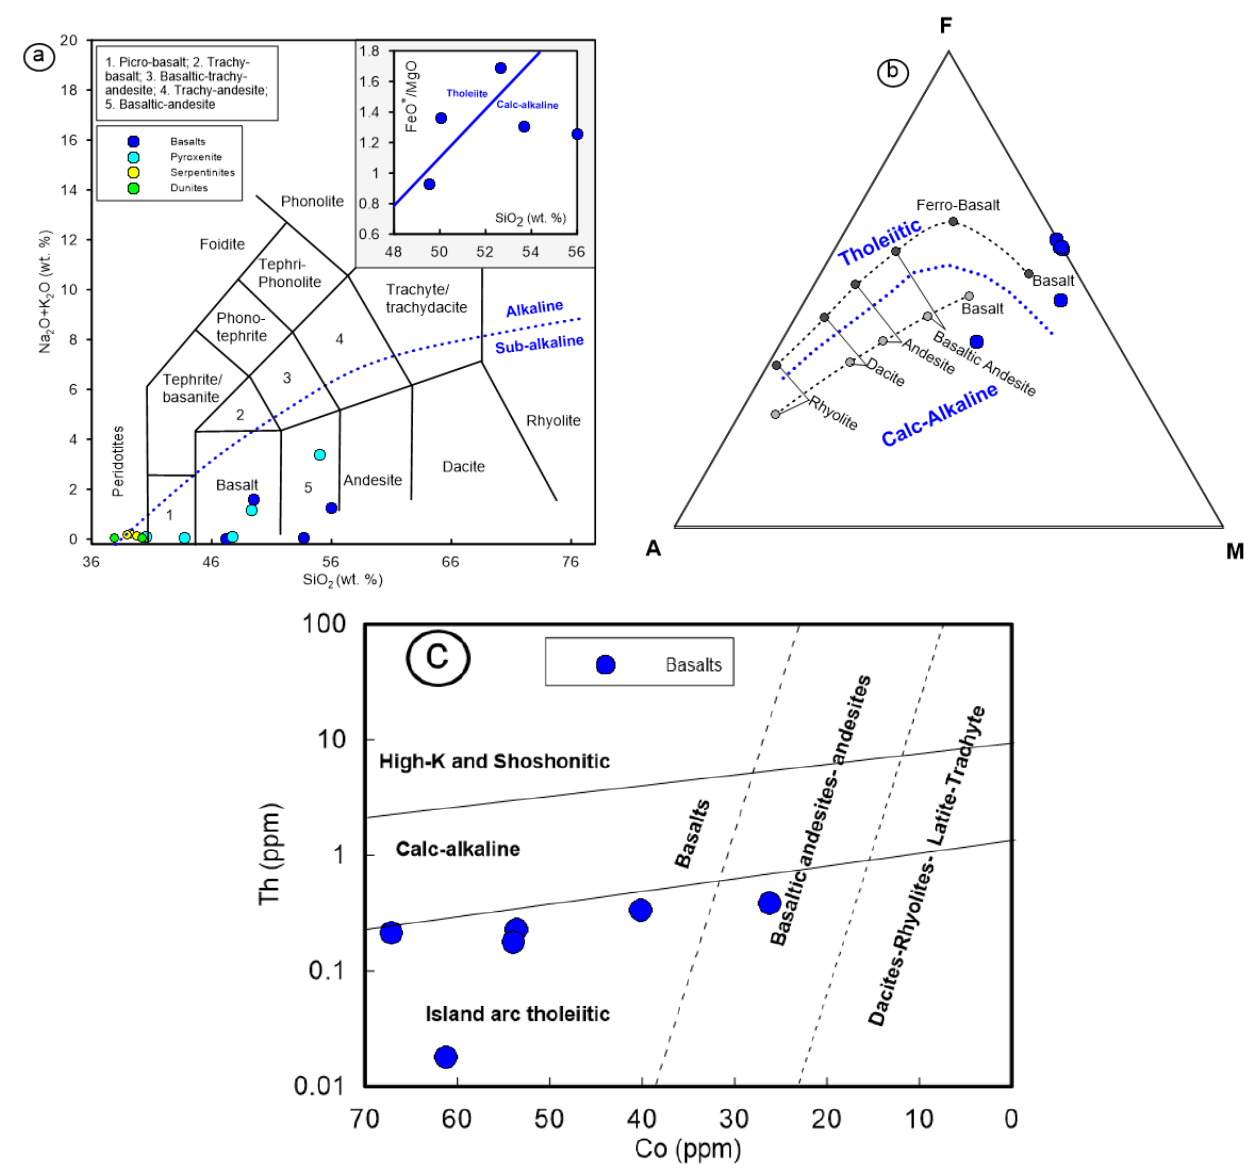
Figure 8. ( a ) Total alkalis vs. SiO 2 (TAS) classification diagram [71] . The dotted line indicates the boundary between alkaline and sub-alkaline fields (after Irvine and Baragar [72] ). Inset shows SiO 2 vs. FeO*/MgO plot with the solid blue line further classifying the sub-alkaline rocks into tholeiite and calc-alkaline respectively (after Miyashiro [9]); ( b ) AFM ternary diagram after Irvine and Baragar [72], where A are the sum of alkali oxides (Na 2 O+K 2 O); F, iron oxide (Fe 2 O 3 ) and M, is magnesium oxide (MgO, the dotted line indicates the boundary between tholeiitic and calc-alkaline rocks; ( c ) The Th-Co discrimination plot [73] for the studied basalts. The dotted lines separate the geochemical boundaries of basalts, basaltic andesites-andesites, and dacites-rhyolites-latites-trachytes. The solid lines separate the compositional boundaries of Island arc tholeiites, calc-alkaline, and high-potassic schoshonites.